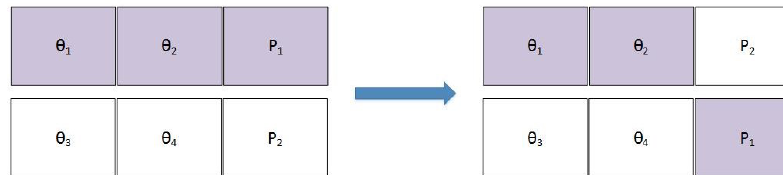
Figure 2. Single Point Crossover Technique.